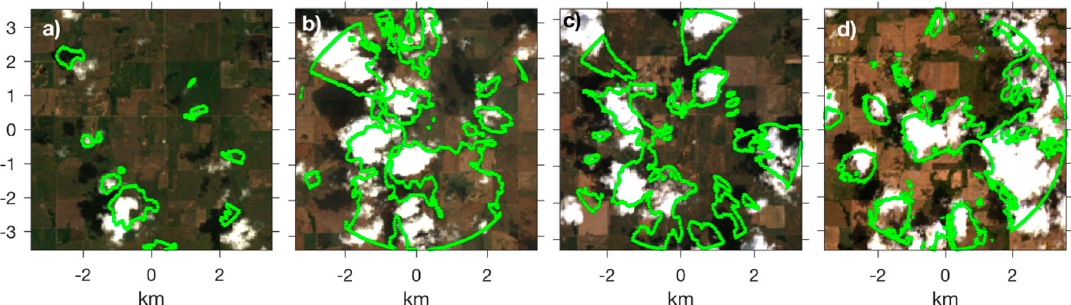
Figure 3. The remaining four Landsat images that comprise the validation data set for the TSI cloud equivalent diameter (CED) calculation. Images are captured on ( a ) 2007/07/21 17:01 ( b ) 2007/09/23 17:00; ( c ) 2009/05/23 16:55; ( d ) 2017/06/14 17:06 UTC. North is up, East is right. Green lines show perimeters of cloud boundaries from the TSI projected images. ( b ) Illustrates erroneous cloud boundary in the southeast quadrant due to sun glare around the shadowband. The 15 May 2006 Landsat image is shown in Figure 1f.